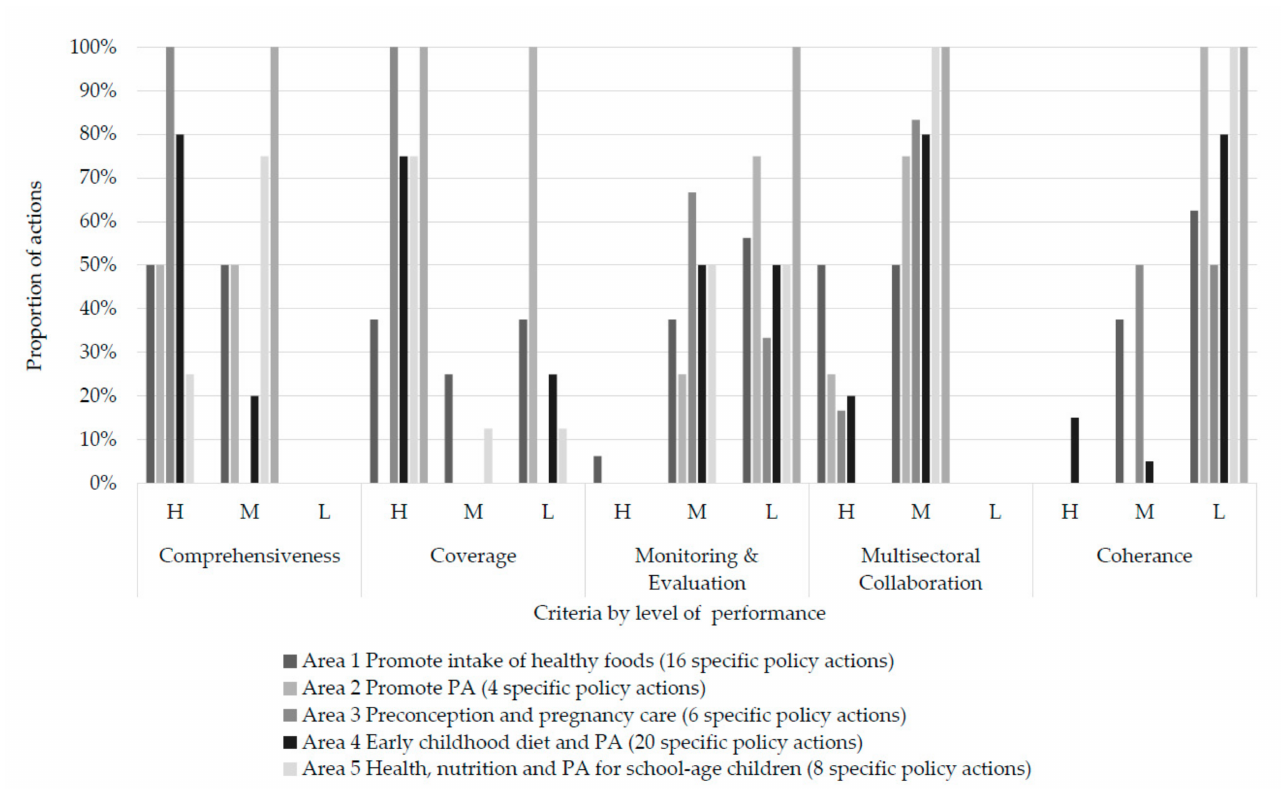
Figure 3. Assessment of policy areas and actions implemented in Thailand by the five criteria for analyzing policy implementation gaps (H—high, M—moderate,